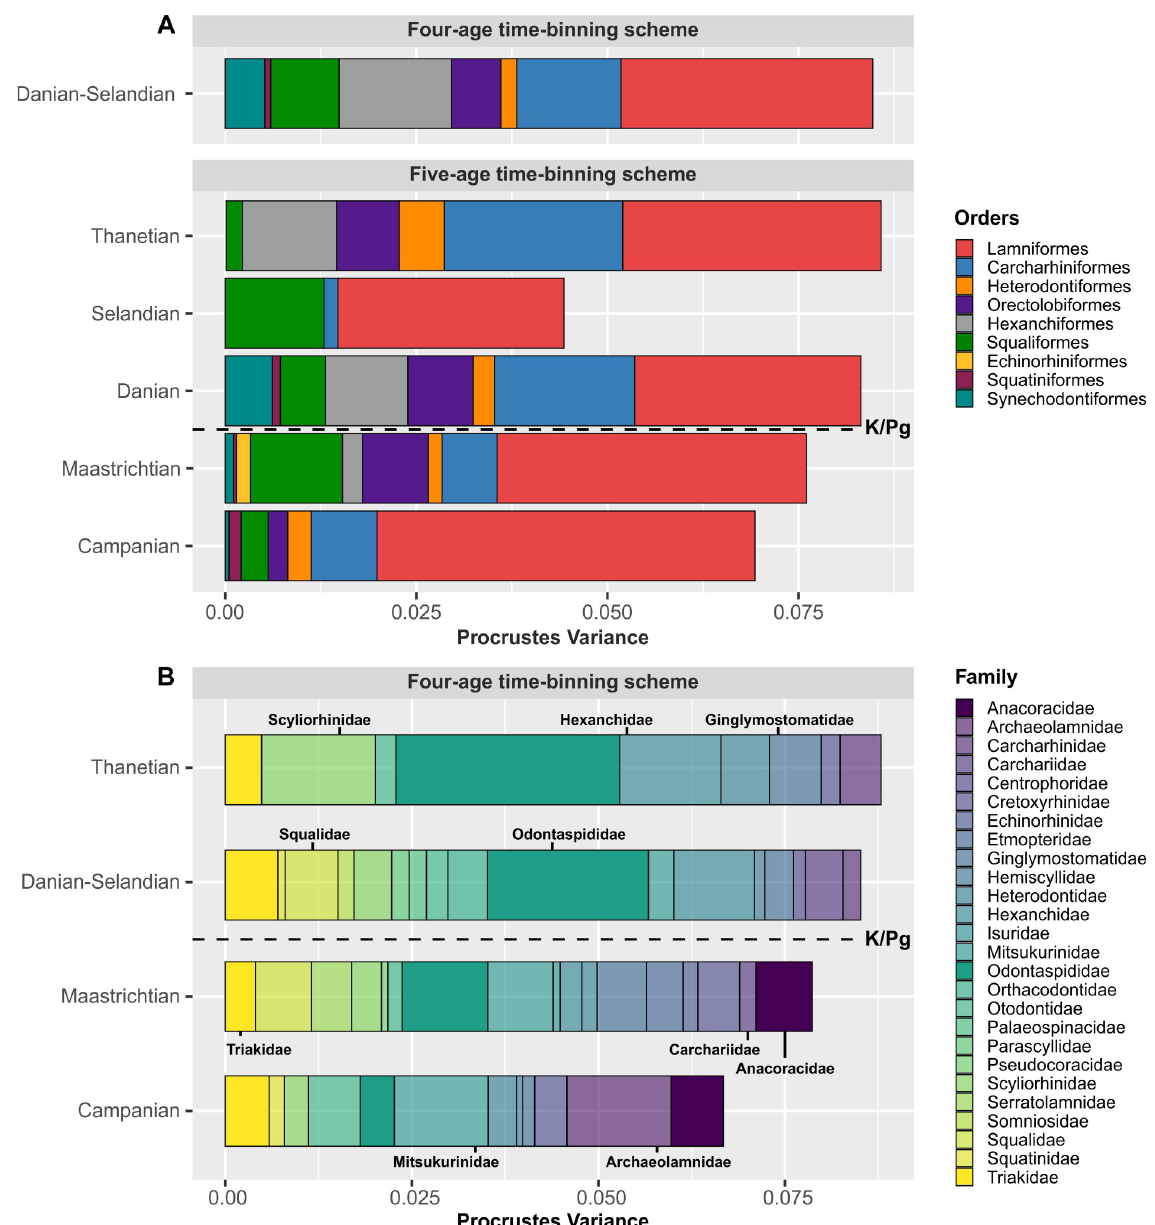
Fig 5. Order- and family-level partial disparity. (A, B) Grouped bar plot depicting clade-level contributions to overall disparity in each time- bin. (B) Families with sample sizes of N < 5 were omitted. Resulting data total = 26 families and 1,039 specimens with the global 4-age time- binning scheme. The data used in this analysis can be accessed online at